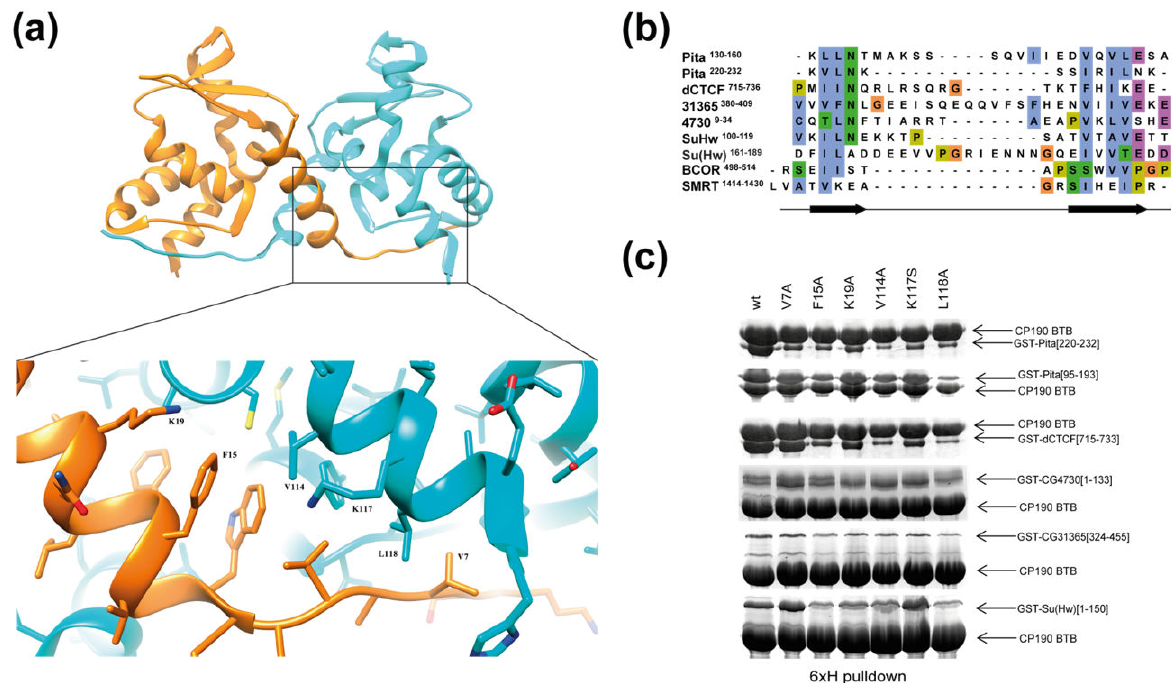
Figure 3. The hydrophobic groove of the CP190 BTB domain is involved in interaction with most of the C2H2 proteins. ( a ) 1.4 Å crystal structure of the CP190 BTB domain dimer with an enlarged view of the peptide-binding groove. Residues subjected to mutagenesis are designated. ( b ) Alignment of core sequences in the C2H2 proteins that interact with the CP190 BTB domain. Amino acids are colored according to their properties. The positions of the predicted beta strands are shown. ( c ) Testing of the impact of point mutations within the CP190 BTB peptide-binding groove on the interaction with C2H2 proteins using a pull-down assay. The uncropped images are shown in the Supplementary Materials Figure